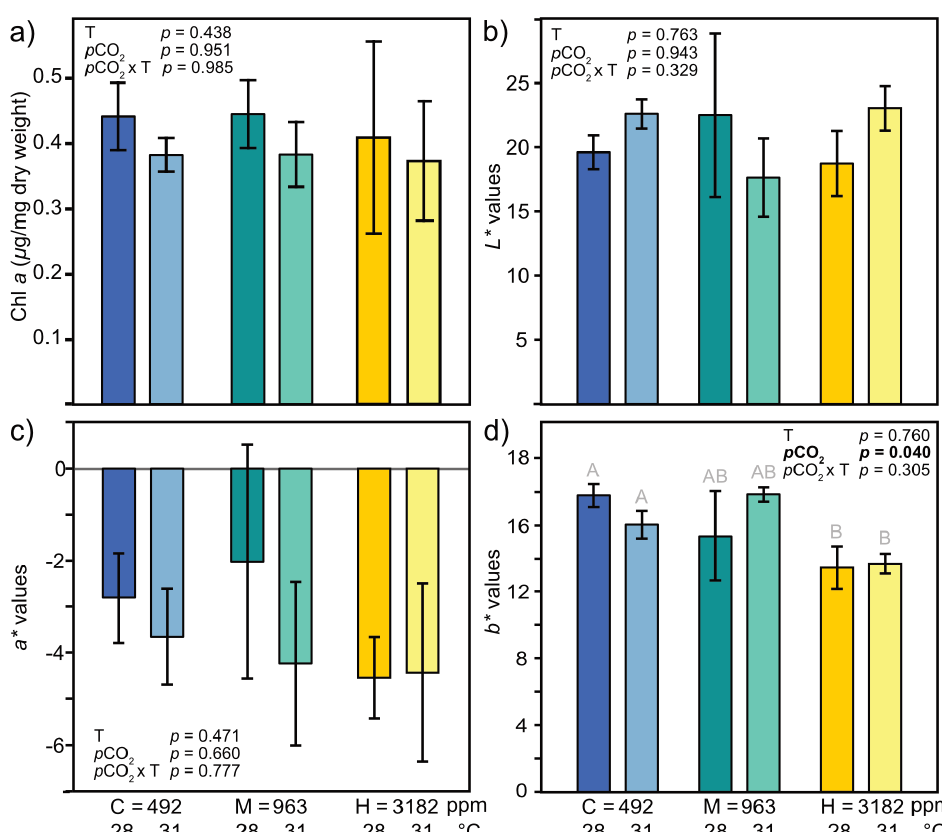
Figure 2. Changes in chlorophyll a (chl a ) and CIE L * a * b * color space values of the Amphistegina lobifera indicate photosymbiont performance in response to elevated p CO 2 (C = 492 ppm, M = 963 ppm, H = 3182 ppm) crossed with 28 ◦ C and 31 ◦ C. ( a ) Chl a concentration is a proxy for photosymbiont biomass (n = 3), ( b ) L * is a measure of whiteness (n = 4), ( c ) a * is a measure of green (-) to magenta (+) (n = 4), and ( d ) b * is a measure of blue (-) to yellow (+) (n = 4). Bar plots represent means with standard errors. Two-way ANOVA p- values are given in the respective panels, with bold values indicating significant effects. Treatments lacking common capital letters are significantly different in the respective post-hoc multiple comparison (Tukeys’ HSD test), with marginal significance if